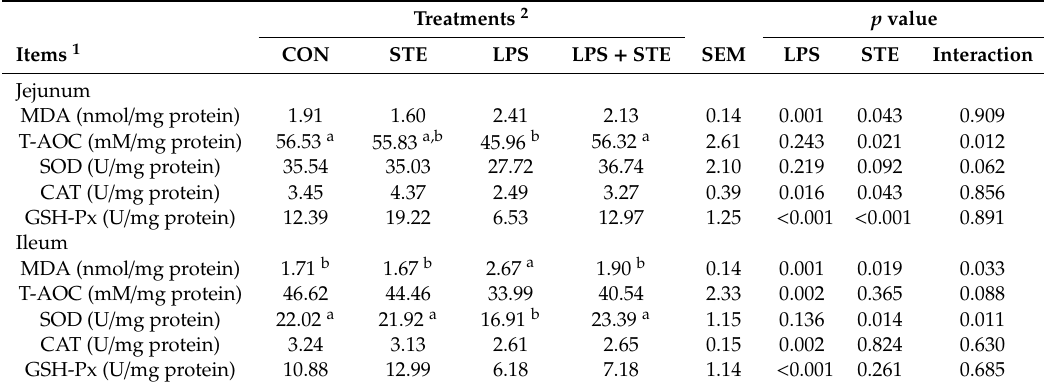
Table 7. E ff ects of stevioside supplementation on intestinal mucosal oxidative status of LPS-challenged broilers.